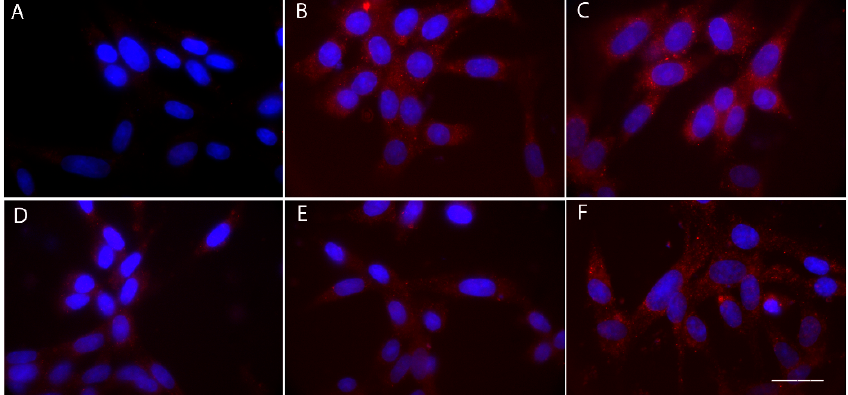
Figure 5. GnRH-induced β -catenin activation and inhibition by antagonists, in HEK293 / GnRHR cells. Cells were treated for 1 h by 1 µ M dose of GnRH, in the presence or in the absence of 1 µ M GnRH antagonist, and immunostaining was performed in fixed samples using a primary antibody against the active- β -catenin and a Cy3-conjugated secondary antibody (red). DAPI was used for nuclei staining (blue). ( A ) Control samples maintained in the absence of hormone and GnRH antagonist (negative control). ( B ) Cells treated with GnRH alone, ( C ) Cells treated for 16 h with 100 nM of the glycogen synthase kinase 3 (GSK3) inhibitor CHIR99021 cells (positive controls for β -catenin activation). ( D – F ) Cells treated with ( D ) both GnRH and Cetrorelix, ( E ) Ganirelixor and ( F ) Teverelix. Images are representative of three independent experiments. Bar = 50 µm.